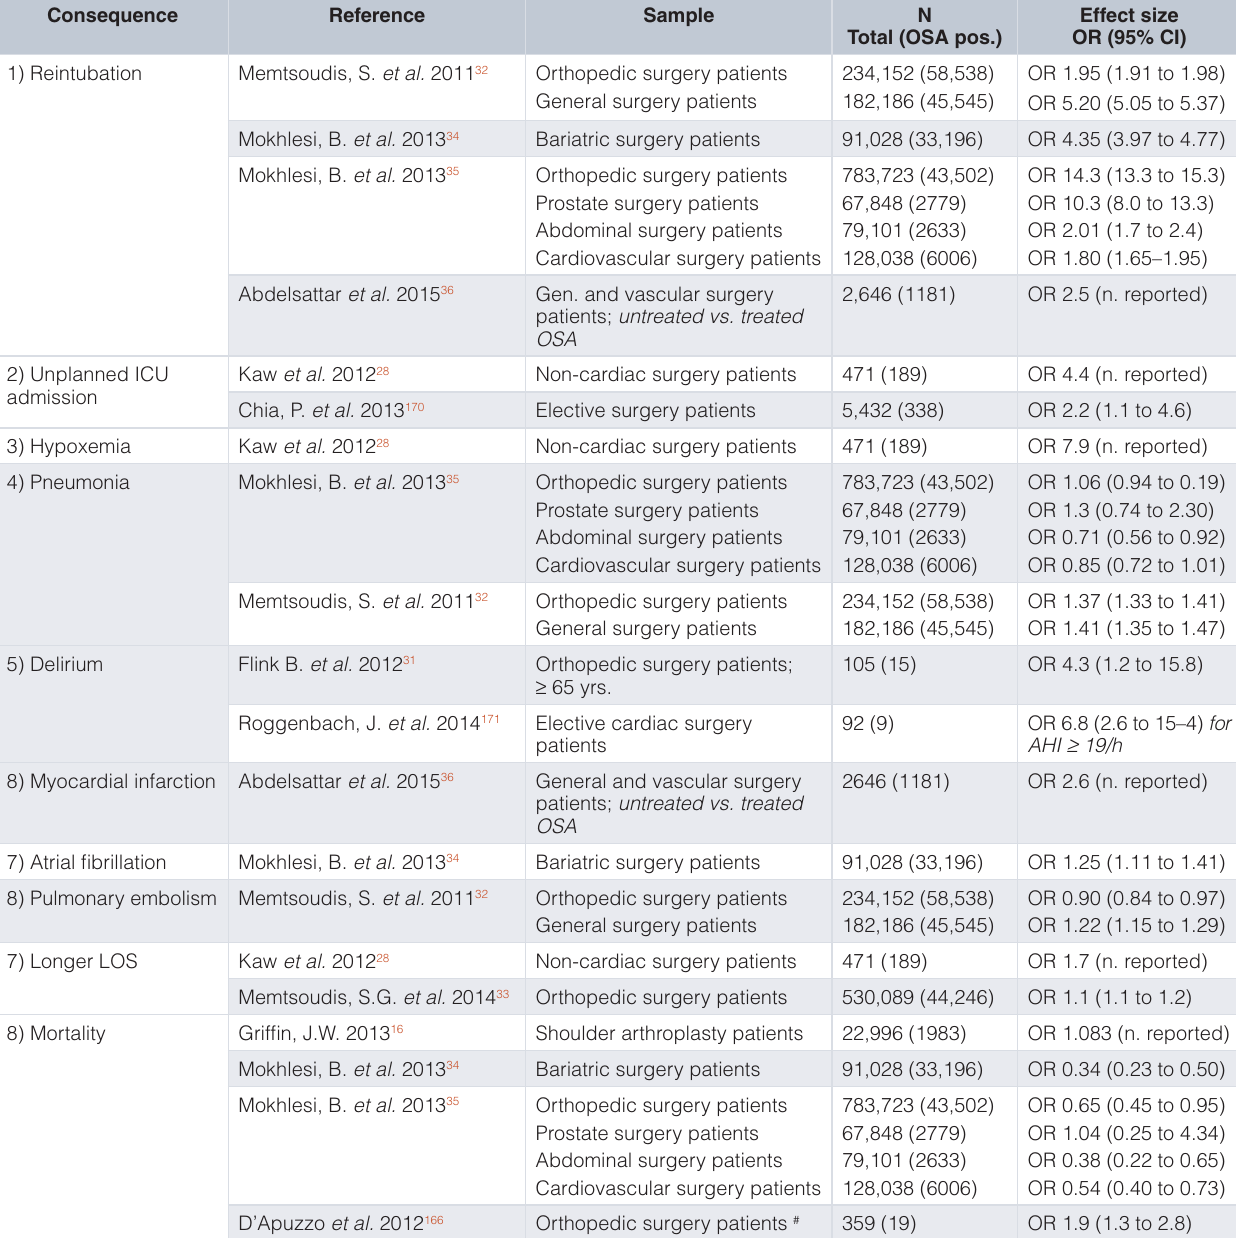
Table 2. Effect of obstructive sleep apnea on the risk for postoperative complication after non-upper-airway surgery.